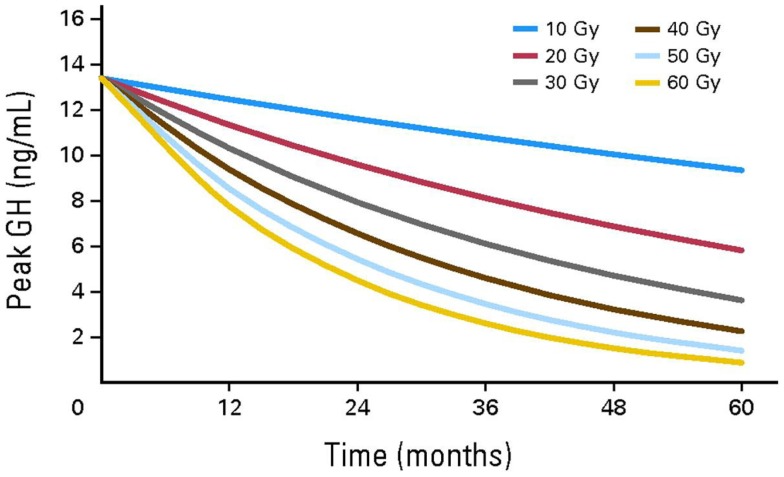
Growth hormone secretion after hypothalamic/pituitary exposures to radiotherapy. Reproduced with permission from Ref. (13) ©2011 by American Society of Clinical Oncology.